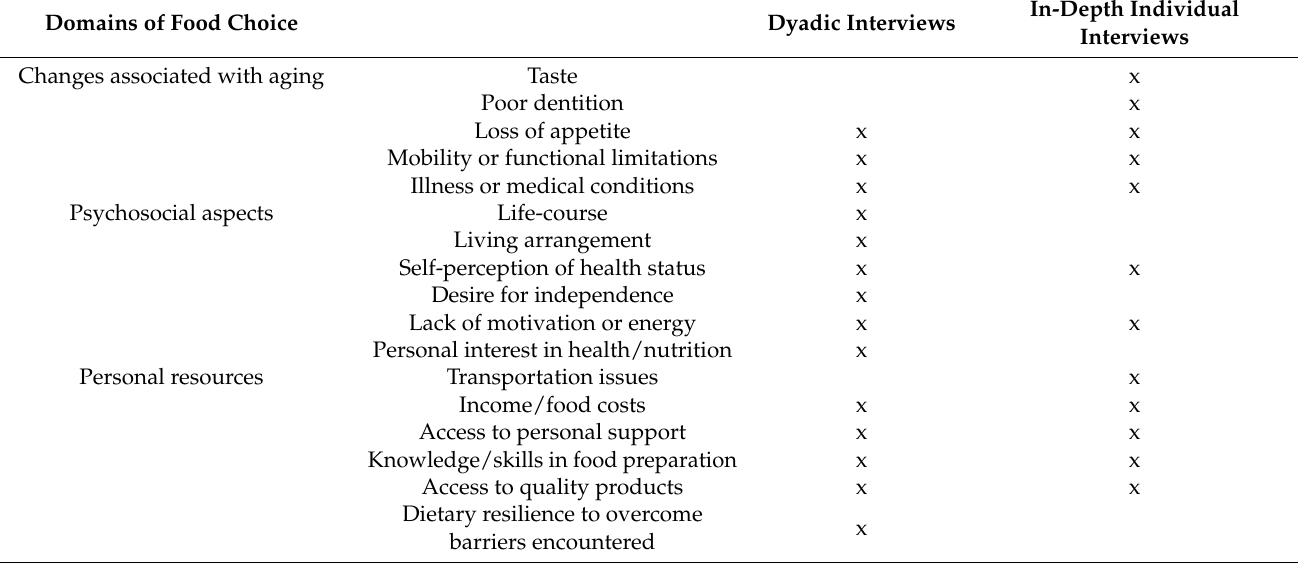
Table 3. Factors contributing to or impeding the food choices of older adults living at home. Domains of Food